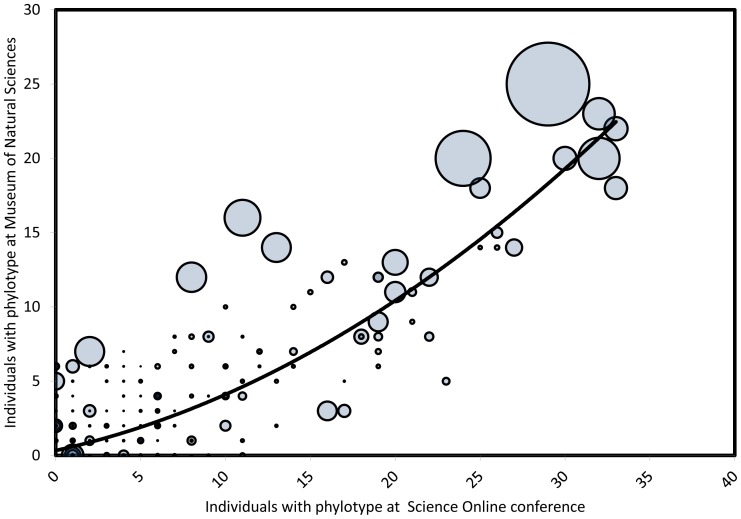
The frequency of bacteria phylotypes (each point  =  a phylotype) in our first sample of human belly buttons predicts most of the variation in the frequency of the same phylotypes in our second sample.The size of circles corresponds to the number of reads of each phylotype, where reads are a proxy for abundance. 1380 points are plotted here, though many fall on top of each other.